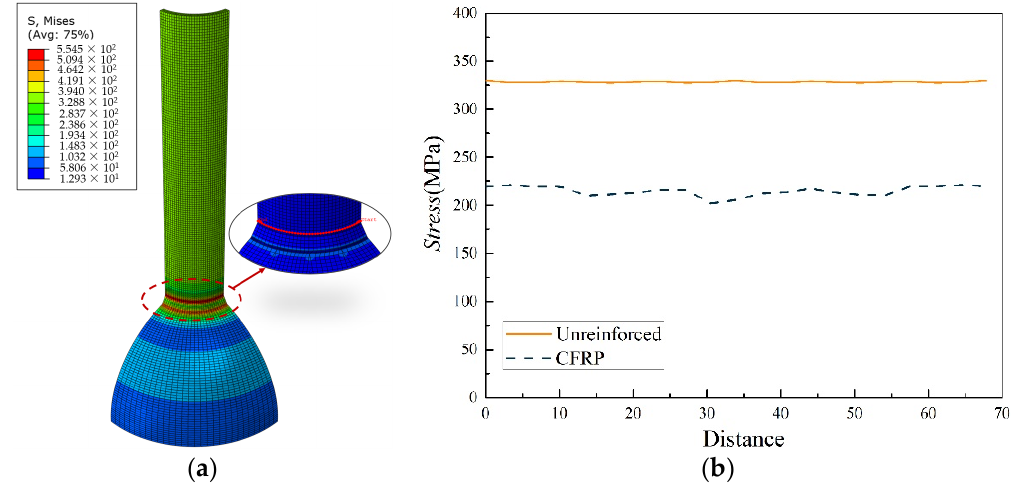
Figure 4. FEA results. ( a ) Stress concentration; ( b ) Stress concentration.